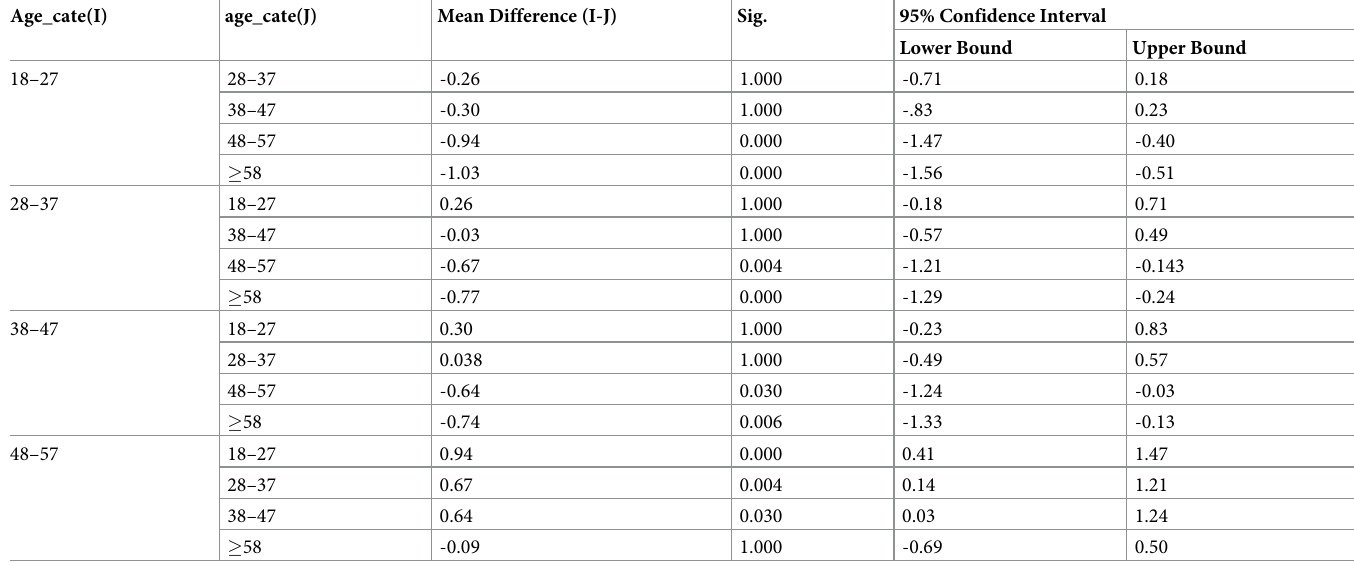
Table 4. Post hoc (Bonferroni) test done for mean CBD diameter difference at different age groups, Northwest Ethiopia, 2019. Age_cate(I) age_cate(J)